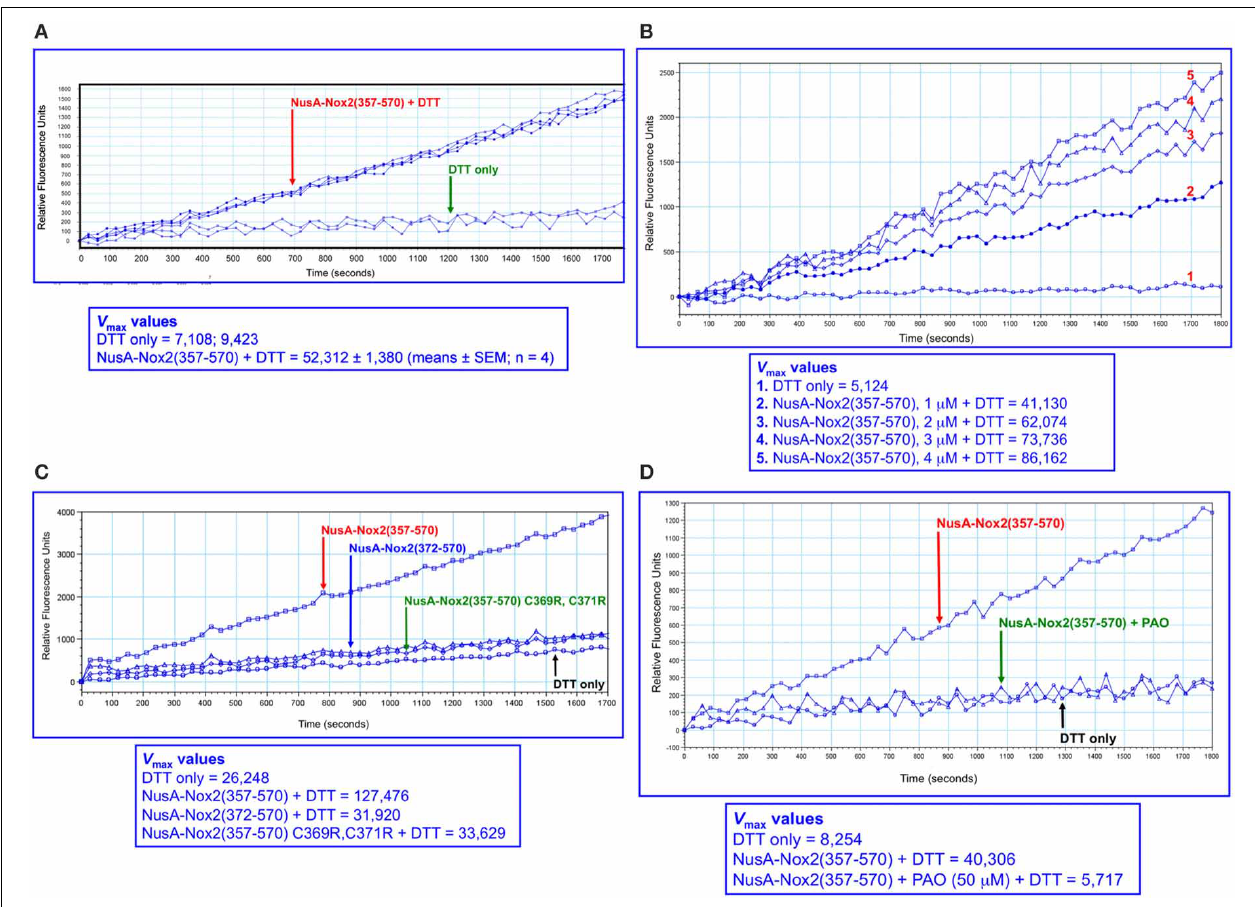
FIGURE 6 | PDI reductase activity of NusA-Nox2(357–570). (A) Recombinant NusA-Nox2(357–570) (2 μ M) was assayed for disulfide reductase activity on dieosin glutathione disulfide (DE-GSSG), in the presence of DTT, as described by Raturi and Mutus (2007) and detailed in the Materials and Methods Section. Briefly, the reaction mixtures contained 800nM DE-GSSG and 12.5 μ M DTT and the kinetics of the increase in fluorescence were followed for 30min, using an excitation wavelength of 519nm and an emission wavelength of 545nm. Results are expressed as V max (milli relative fluorescence units per min). (B) The dose dependence of the PDI reductase activity of NusA-Nox2(357–570) was assayed on DE-GSSG in the presence of DTT, as described in (A) . The concentration of NusA-Nox2(357–570) was varied from 1 to 4 μ M. The results of one